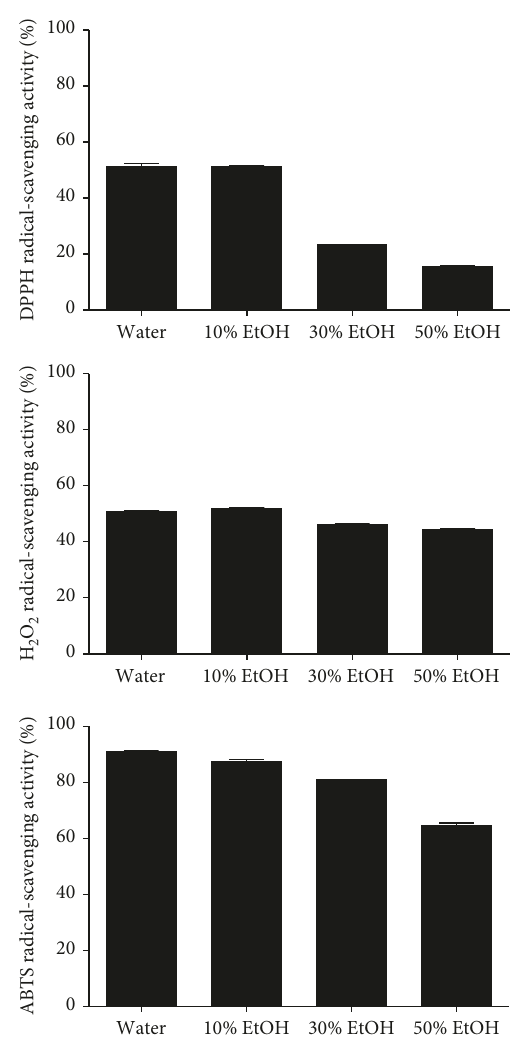
Figure 2: DPPH, H 2 O 2 , and ABTS radical-scavenging activity of the turmeric leaf extracts were measured to confirm the antioxidant effect of the turmeric leaf extracts. Turmeric leaves were extracted with different solvents to confirm the extracting solvent. The leaves were extracted with water and 10%, 30%, and 50% ethanol. The experiment data were measured in triplicates. The one-way ANOVA analysis was applied with Tukey’s post hoc analysis. Each data shown in this figure were expressed as mean ± SD in 95% significance. ∗ p value < 0.05.